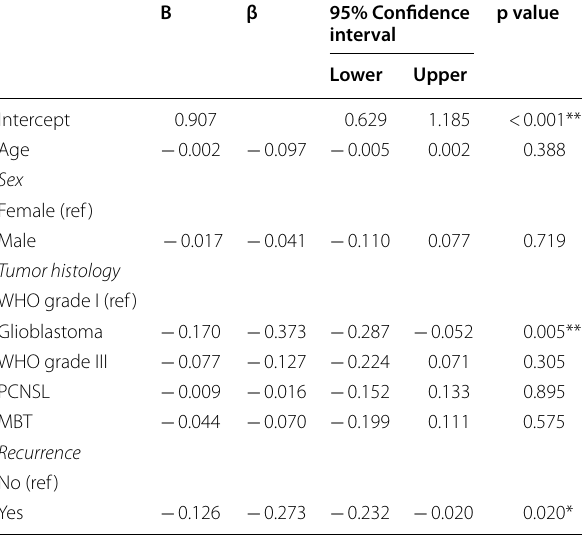
B: Partial regression coefficient, β: Standardized regression coefficient, PCNSL: Primary central nervous system lymphoma, MBT: Metastatic brain